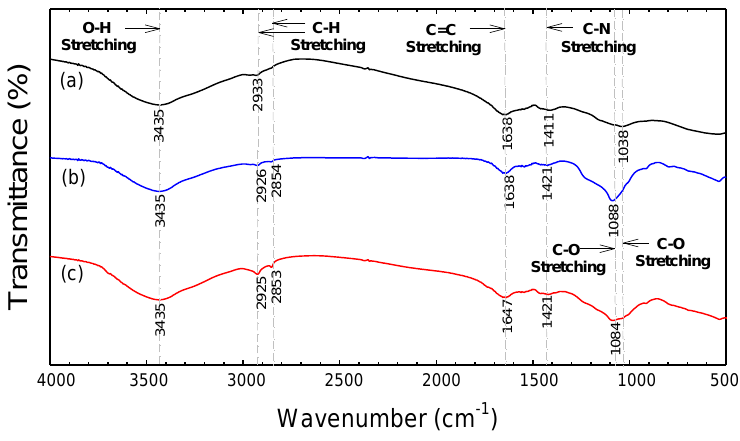
Figure 5. FTIR results of the harvested MB samples. ( a ) MB 1 ; ( b ) MB 2 ; and ( c ) MB 3 .